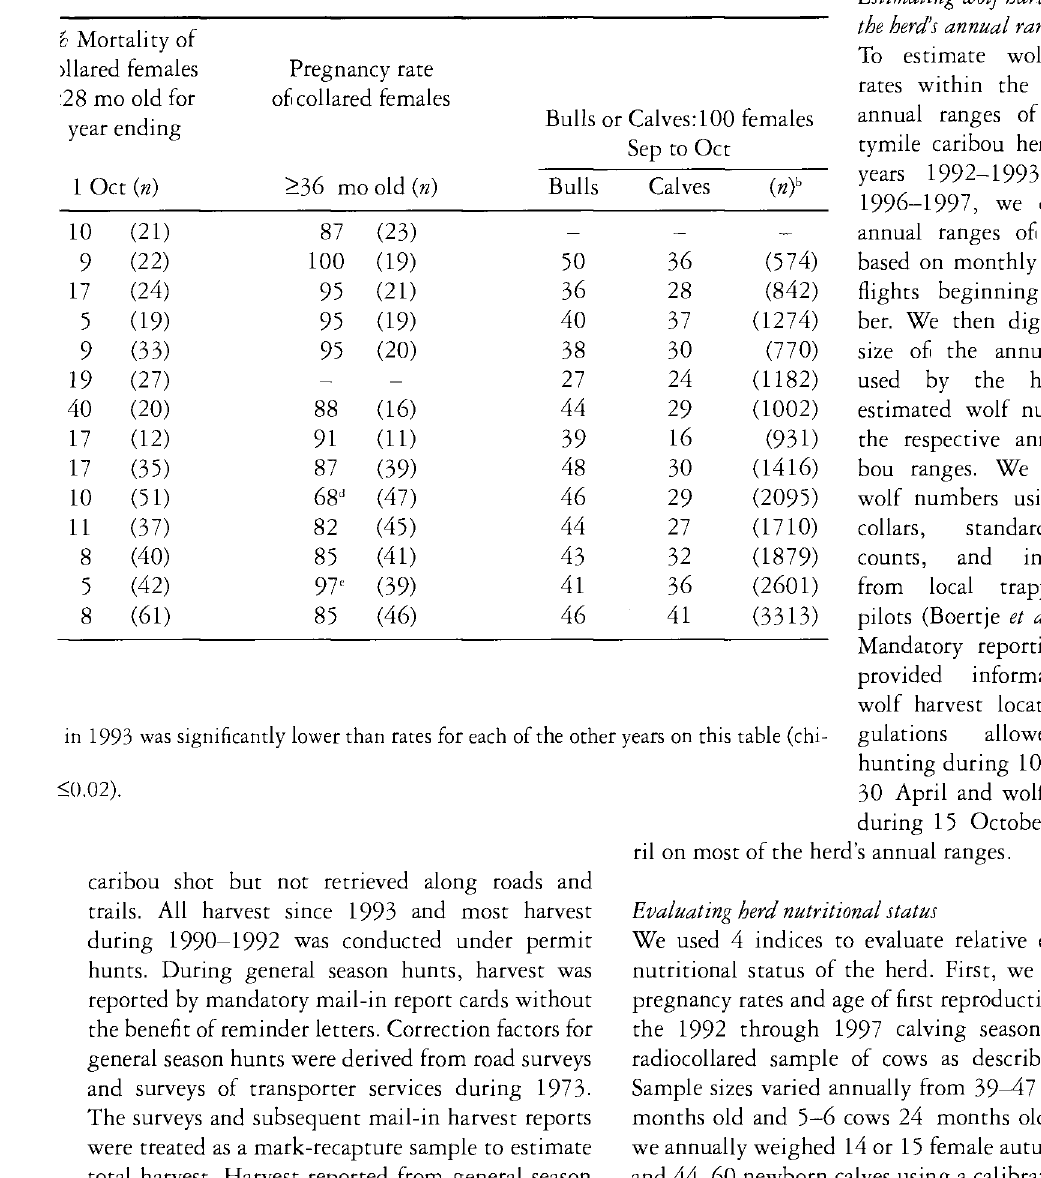
Table 2. Timing of mortality of radiocollared calves in rhe Fortymile caribou herd,